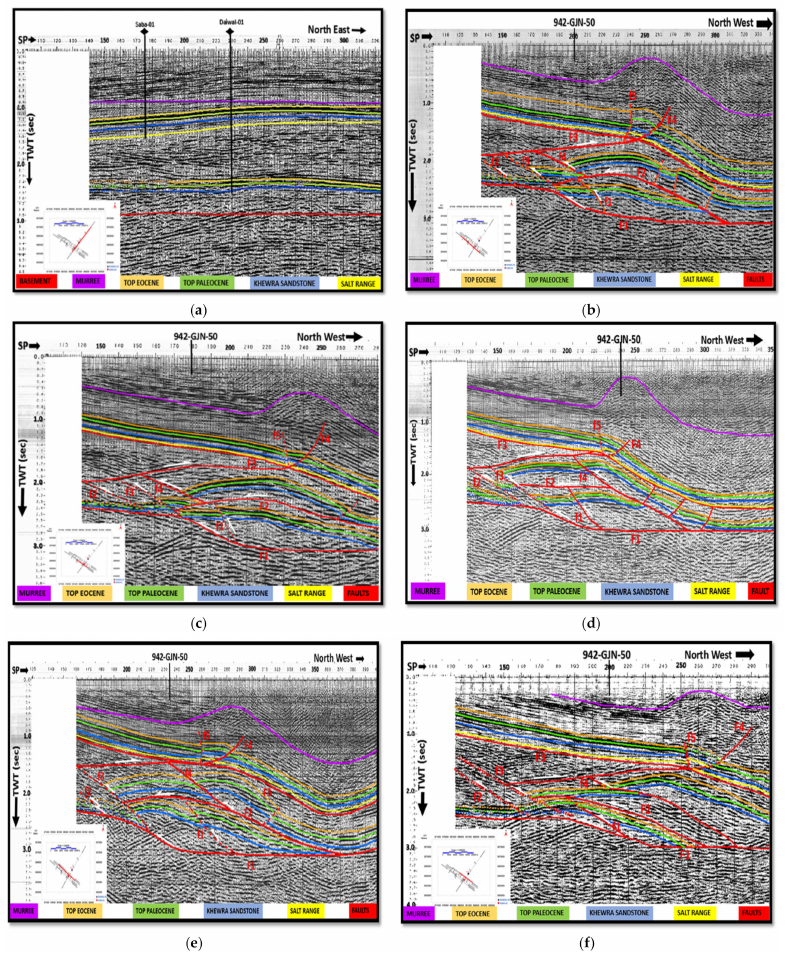
Figure 5. Interpretation of the seismic lines: ( a ) 942-GJN-50 line, ( b ) 942-GJN-29 line, ( c ) 942-GJN-48 line, ( d ) 932-GJN-12 line, ( e ) 932-GJN-34 line, and ( f ) GO-925-GJN-11